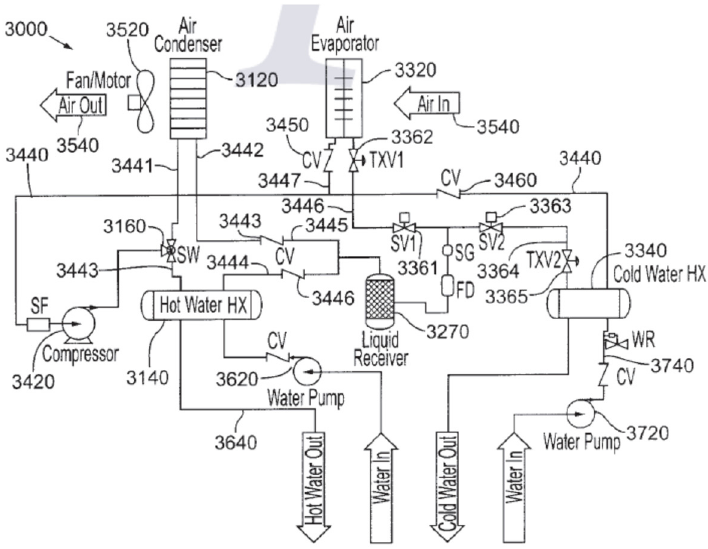
sented by Jungwirth (US6751972) in 2004 (Figure 20) [64]. The same operating logic as in